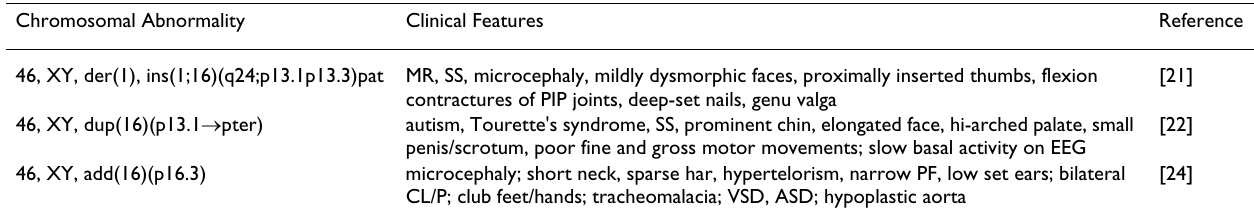
Table 2: Summary of cases with relatively isolated trisomy 16p13. Chromosomal Abnormality Clinical